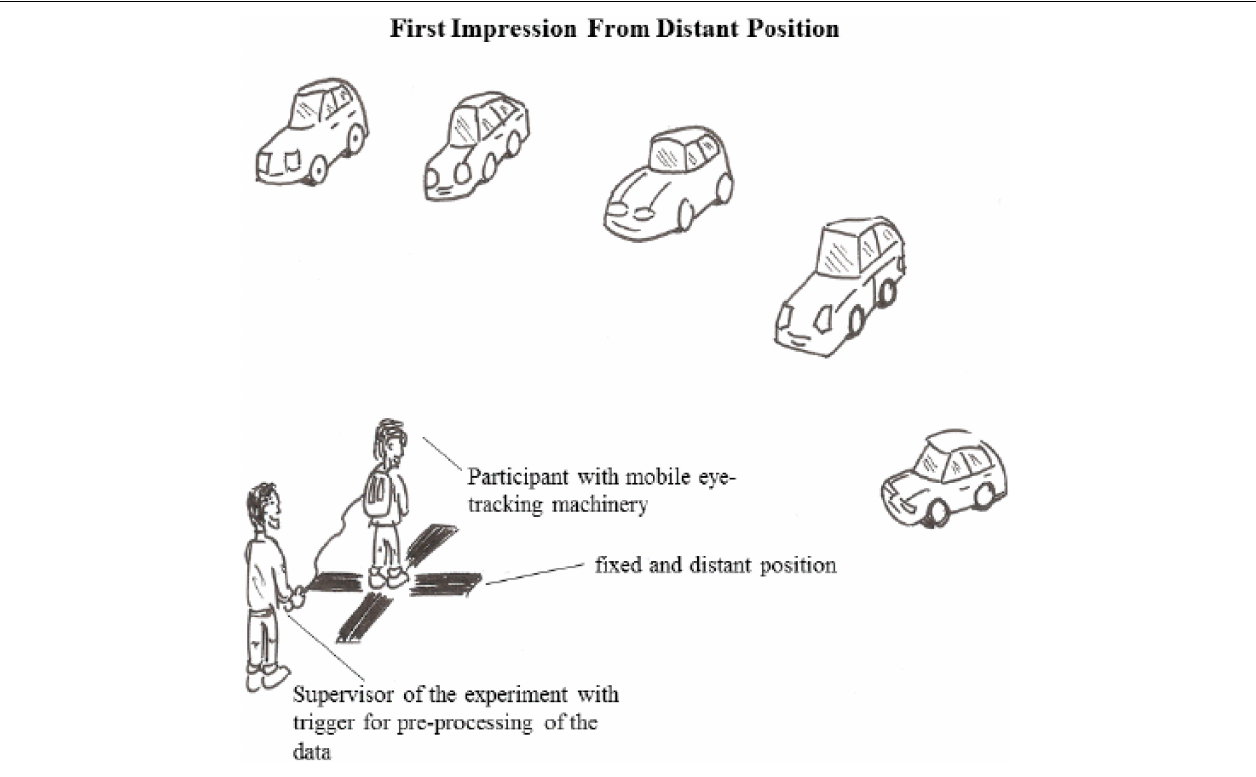
FIGURE 1 | First phase of the experimental setup (own